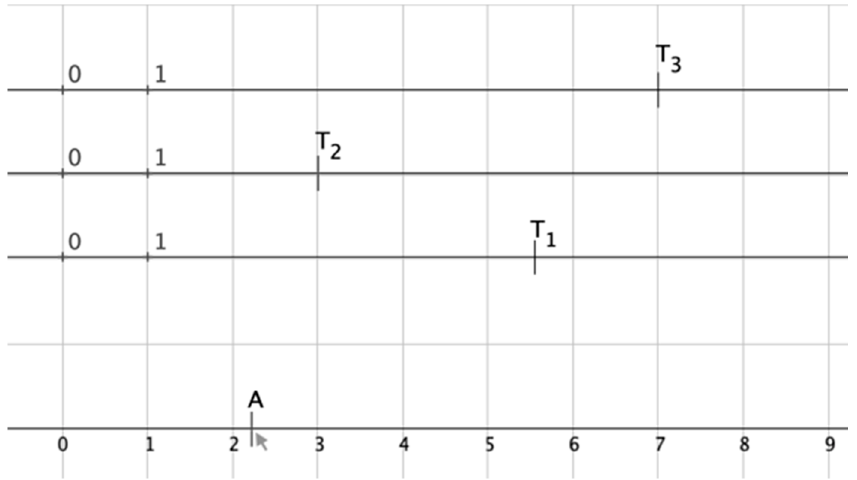
Figure 5. A screenshot of the DGpp of three functions of the same variable. T 1 , T 2, and T 3 represent three different telephone charges all varying depending on time A. The tick representing time is the only draggable one.